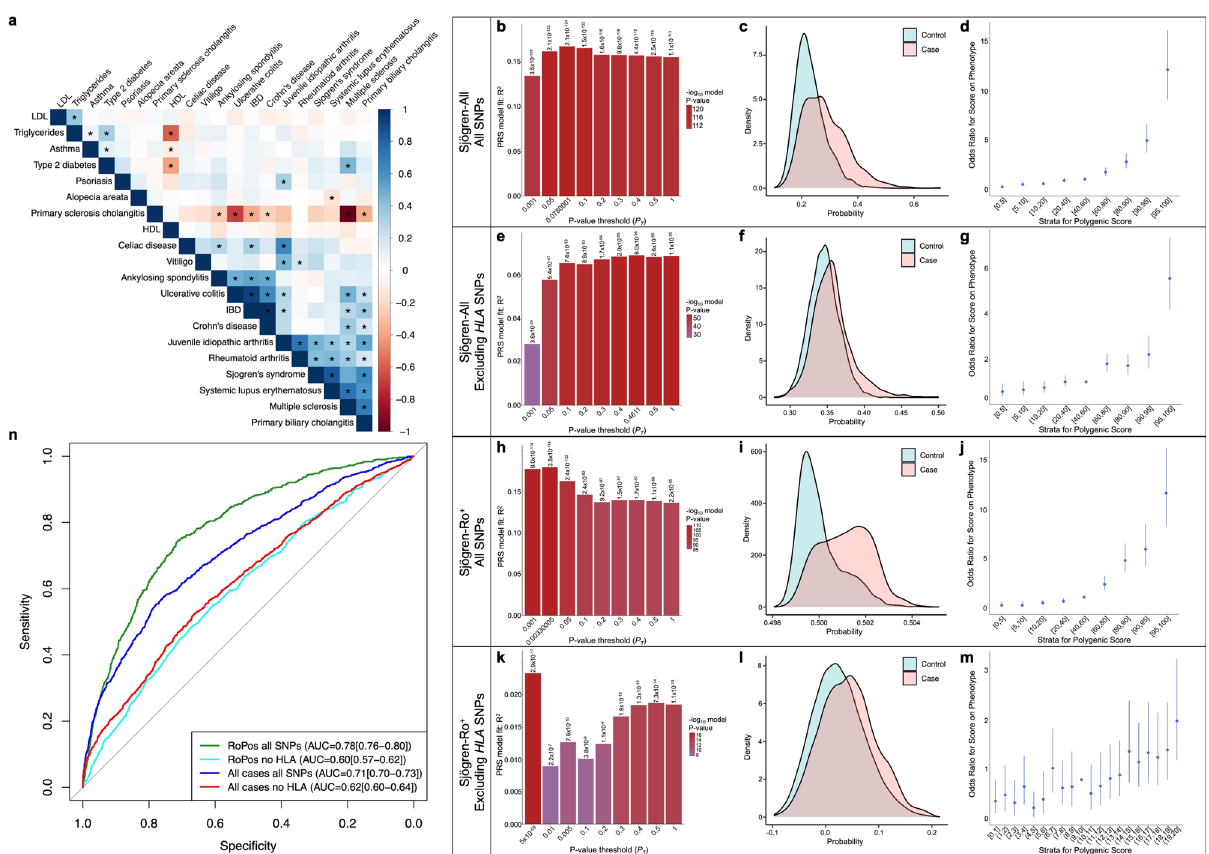
Fig. 3 Polygenic risk score analysis of the Sjögren-SNPs in all genotype Sjögren ’ s cases and Ro + Sjögren ’ s cases with or without the HLA region. a Heatmap of LDSC-estimated genetic correlations between Sjögren ’ s and 19 other immune-mediated diseases and other common traits using European GWAS summary data from the 1000 Genomes Project. Box color indicates magnitude of correlation; * indicates signi fi cant P -value after Bonferroni correction. b – m Polygenic risk scores (PRS) were calculated for all genotyped individuals from the Sjögren-All ( b – g ) or Sjögren-Ro + ( h – m ) subsets, divided 2/3 into training and 1/3 into testing datasets, using LD-pruned genotyped SNPs ( r 2 > 0.2) including ( b – d , h – j ) or excluding ( e – g , k – m ) SNPs from the HLA region (6p21.3 – 22.3.). ( b , e , h , k ) Bar plot of multiple P -value thresholds ( P T ) for PRS prediction of Sjögren ’ s. c , f , i , l Histogram of the PRS distribution in Sjögren ’ s cases (orange) and controls (teal). d , g , j , m Strata plot of the odds ratio (OR) when comparing PRS from different quantile ranges. Bars indicate the 95% con fi dence intervals of the OR from each quantile range. n Area under the receiver operating characteristic curve (AUROC) values of PRS using LD-pruned genotyped Sjögren-SNPs including SNPs from 6p21.3 – 22.3 in all genotyped Sjögren ’ s cases (dark blue) or Ro + Sjögren ’ s cases (green) relative to population controls, and LD-pruned genotyped Sjögren-SNPs excluding SNPs from 6p21.3 – 22.3 in all genotyped Sjögren ’ s cases (red) or Ro + Sjögren ’ s cases (light blue) relative to population